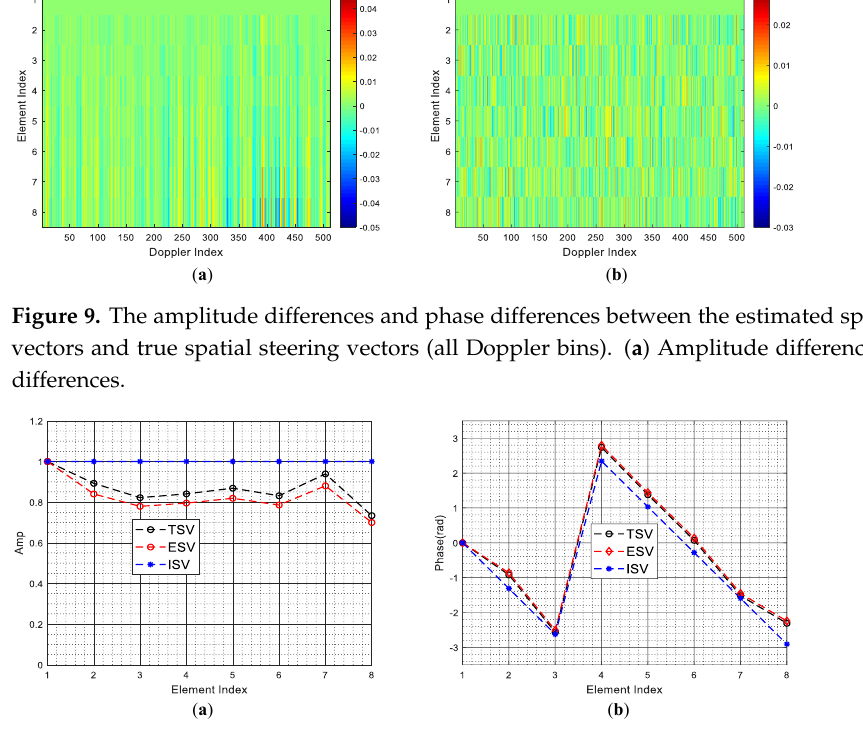
Figure 10. Performance comparison on steering vector estimation. ( a ) Amplitude; ( b ) Phase. TSV denotes the true steering vector with array errors, ESV denotes the estimated steering vector with array errors, and ISV denotes the ideal steering vector without array